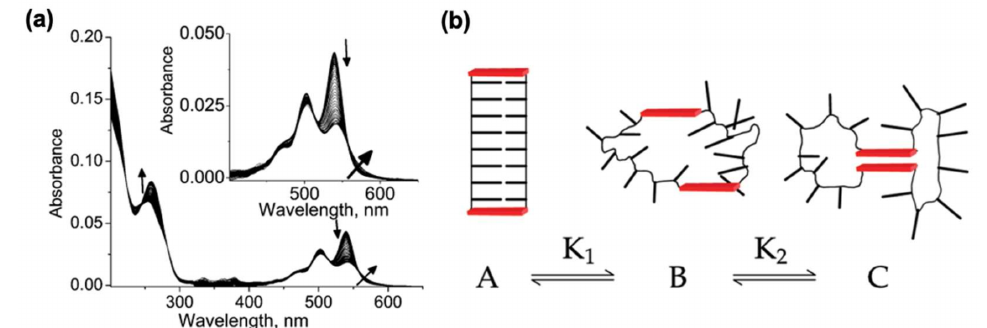
Figure 9. ( a ) Temperature dependent absorption spectra of the conjugate encompassing 13 A–T base pairs in 10 mM phosphate at pH 7.2. Arrows indicate the changes occurring upon heating from 5 to 95 ◦ C. ( b ) Model of the three-state generated from base pair dissociation and PDI–PDI association of dumbbell possessing 8 A–T base pairs. PDI is represented in red [79]. Copyright © 2010, American Chemical Society.